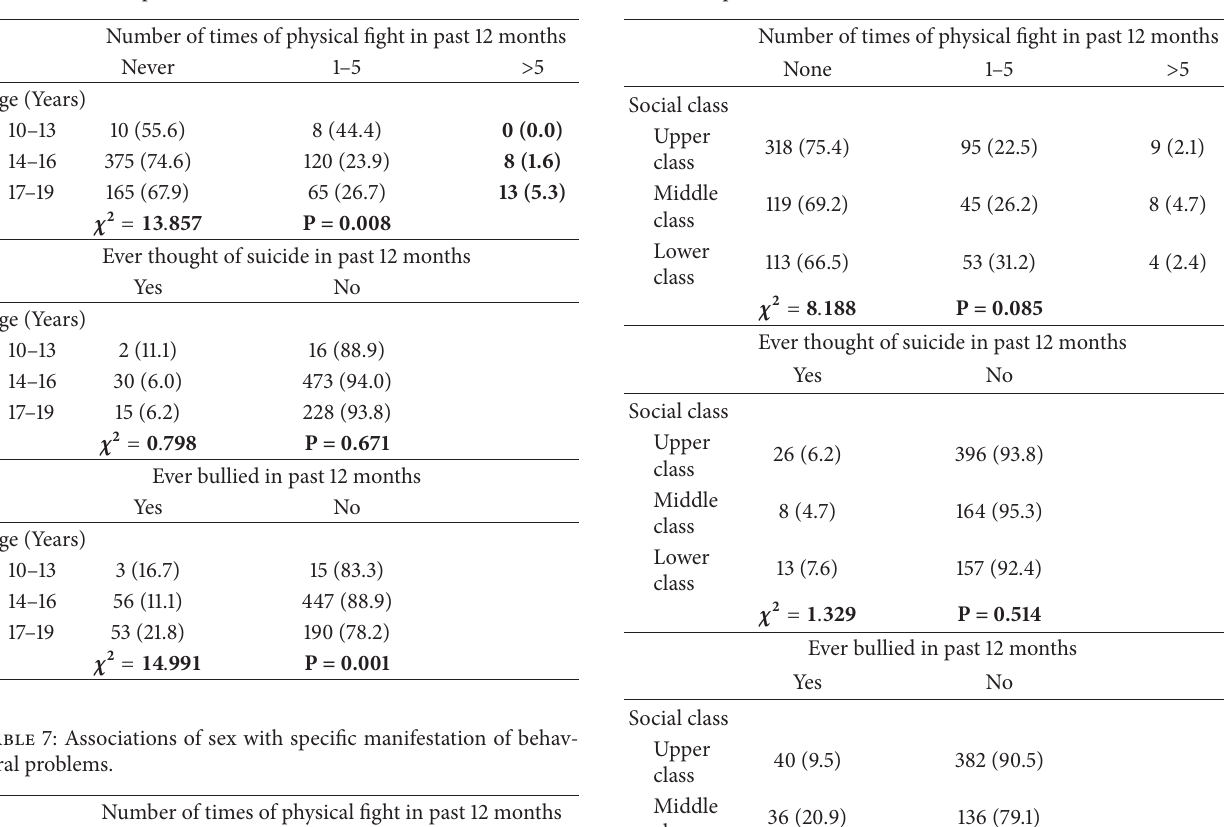
Table 6: Associations of age in categories with specific manifesta- tion of behavioral problems.